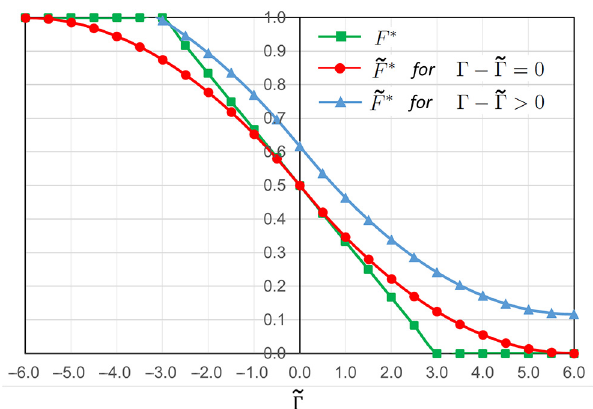
Figure 3 Market level of employer-provided parking without and with FAV (assuming DC (cid:7)